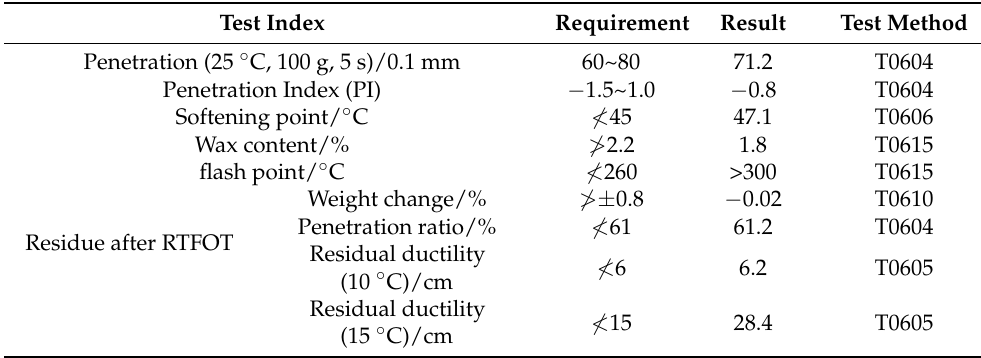
Table 2. Properties of pure asphalt.